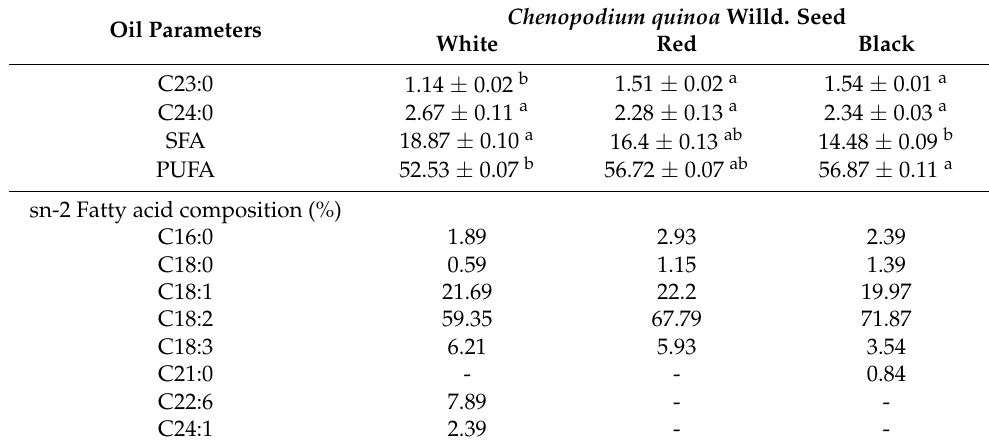
Table 1. Cont. Oil Parameters